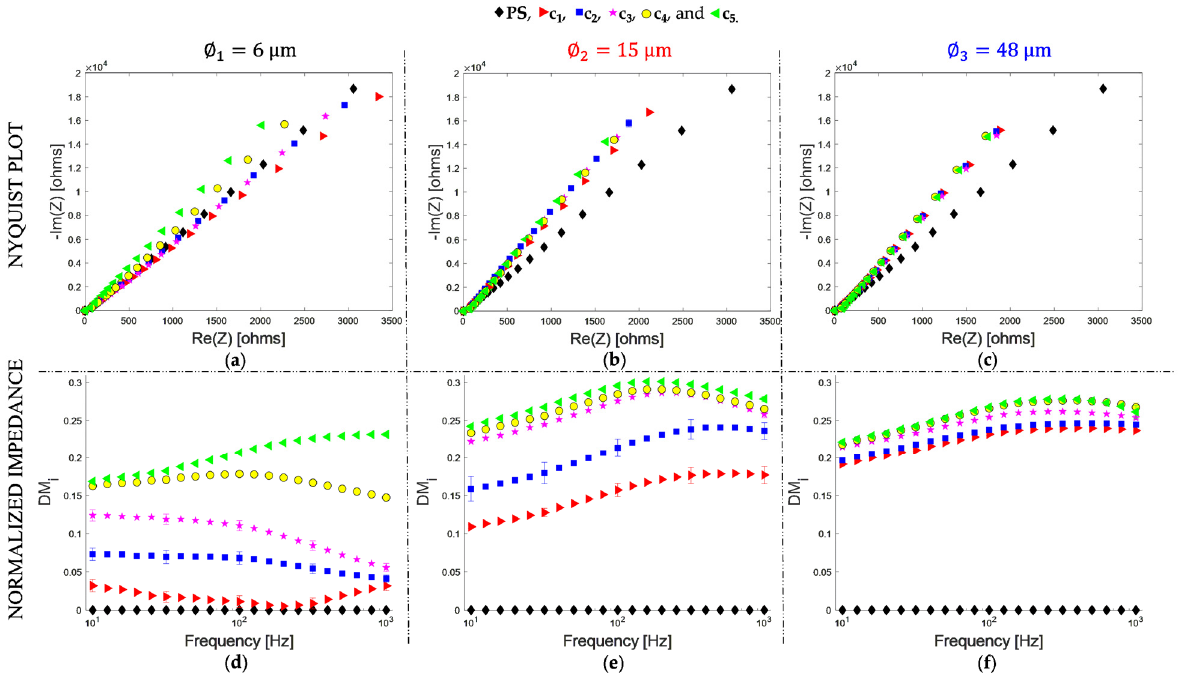
Figure 4. The electrical impedance spectrum of PMMA particle suspensions in PS is represented as Nyquist Plot ( a – c ) and as DM i ( d – f ) for ∅ 1 ( a , d ), ∅ 2 ( b , e ), and ∅ 3 ( c , f ). Concentrations are represented by the